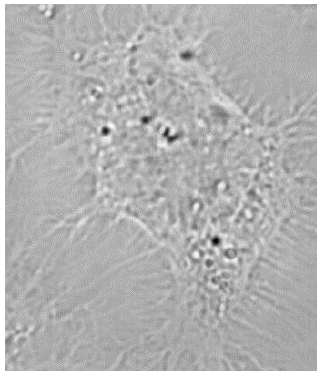
Figure 6. Optical microscope image of a cell that has not been exposed to PS. Black dots are normally visible inside cells although they have not been exposed to PS.